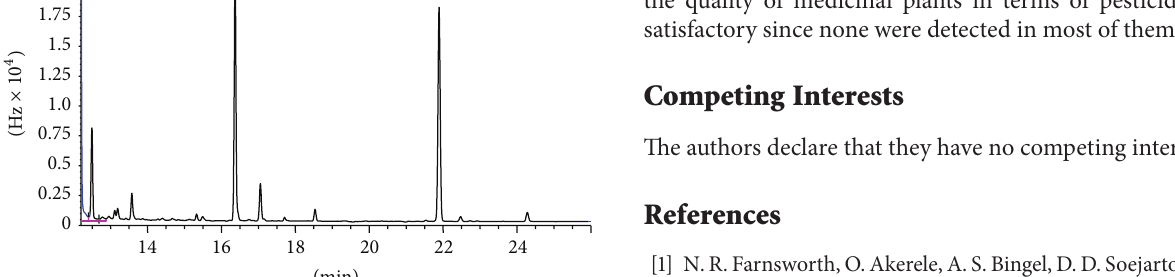
5 min) were applied to the roots of real samples, which are Pterocarpus angolensis, Maerua angolensis, Terminalia sericea, Cassia abbreviata , and Gymnosporia senegalensis . Only dieldrin was confirmed with MS and its concentration was found to be 150.5±8.4 ng g −1 in Terminalia sericea B with ECD (Figure 7). However, some low levels of pesticides were detected with ECD in other plants, but these results could not be reliably confirmed since MS could not confirm the peaks due to high detection limits for the compounds of interest in MS as compared to